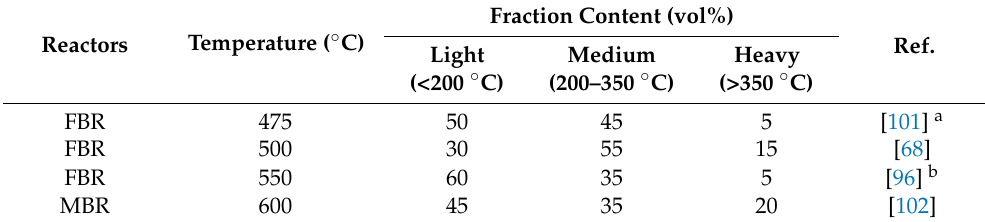
Table 4. Contents of pyrolysis oil fractions at different